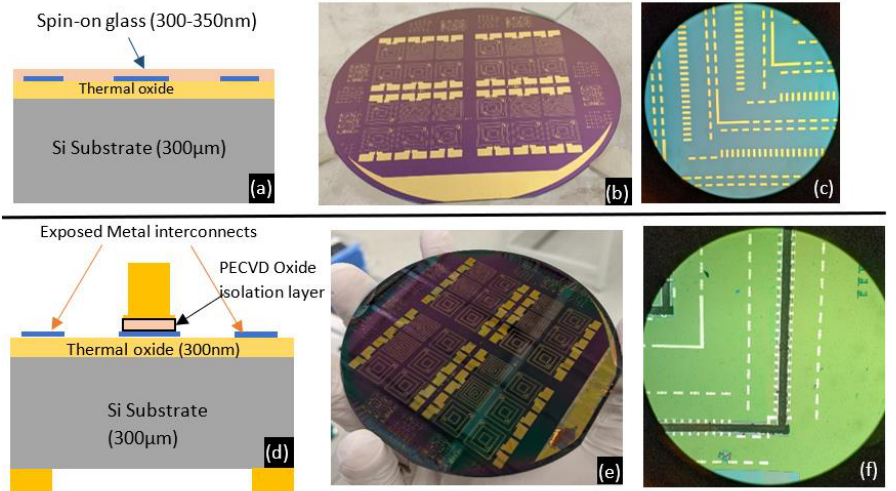
Figure 12. ( a ) Schematic view of the wafer at the end of Stage 1. ( b ) 4” wafer after Stage 1 with Ti/Ni/Au interconnects. ( c ) Zoomed-in view of the interconnects. ( d ) Schematic view after Stage 2 of fabrication. ( e ) Wafer-level view post Stage 2 after completing bonding ring formation on both sides of the wafer followed by etching of the PECVD oxide to reveal the metal interconnects. ( f ) Zoomed-in top view of the wafer at the end of Stage 2.